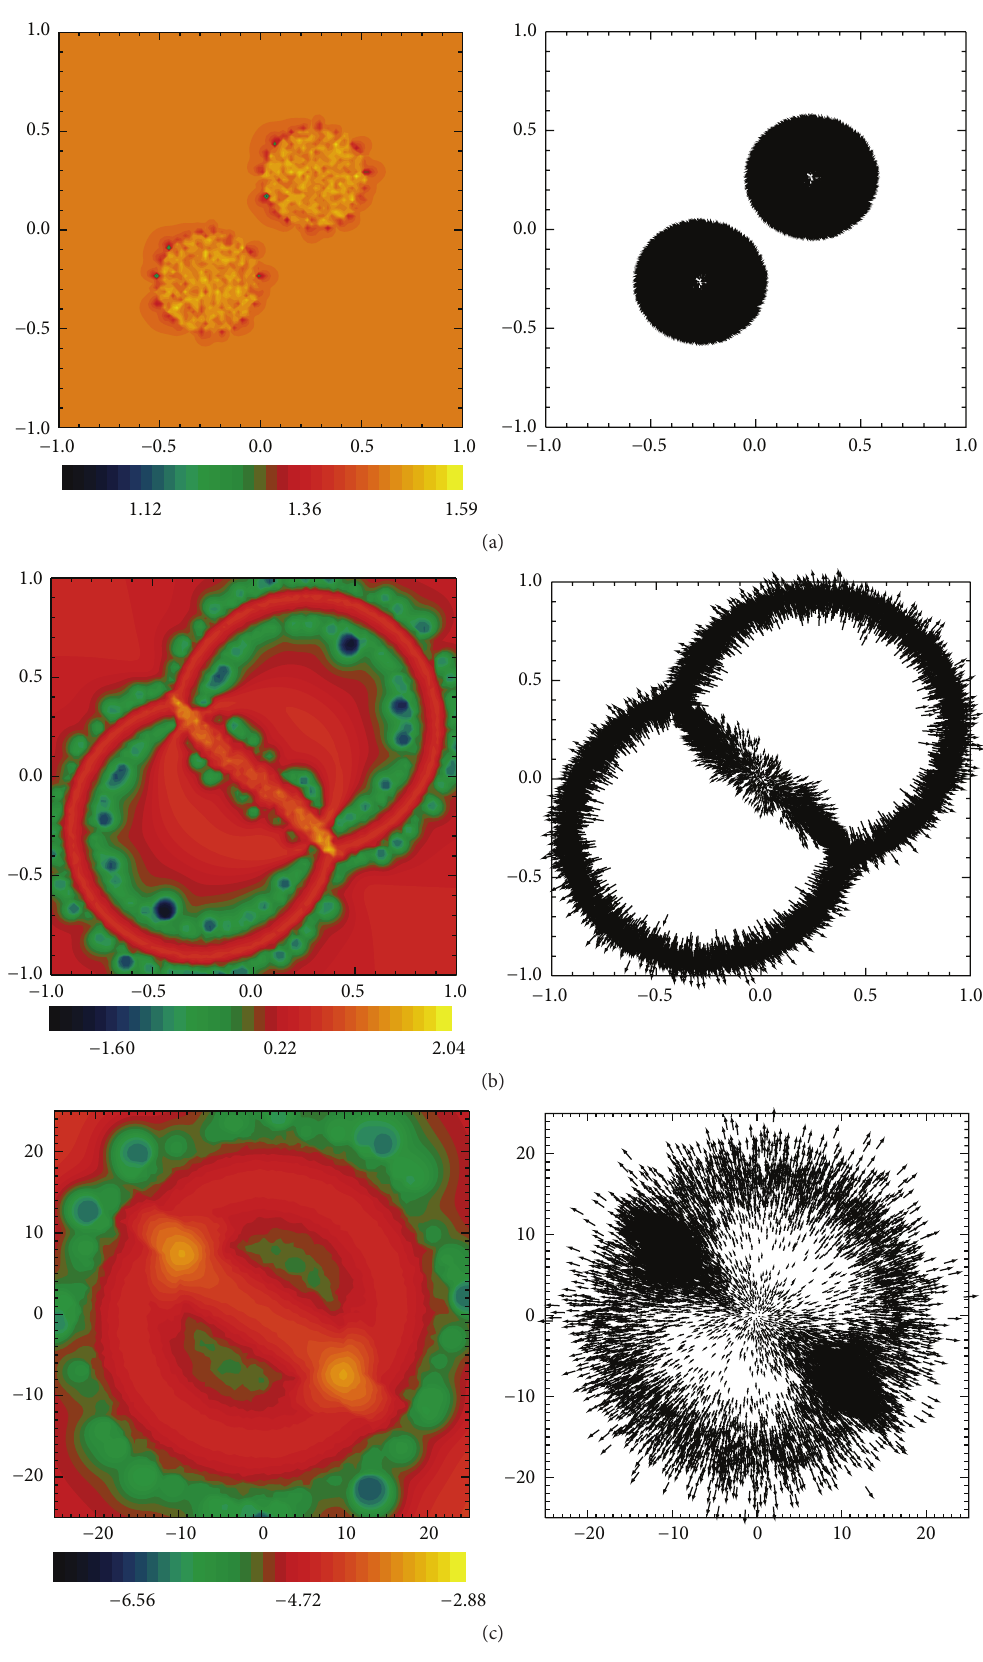
Figure 9: Iso-density and velocity plots for a binary system formed by the source T3 model at times (a) 0sec.; (b) 9870 sec.; and (c) 4.67𝑒5